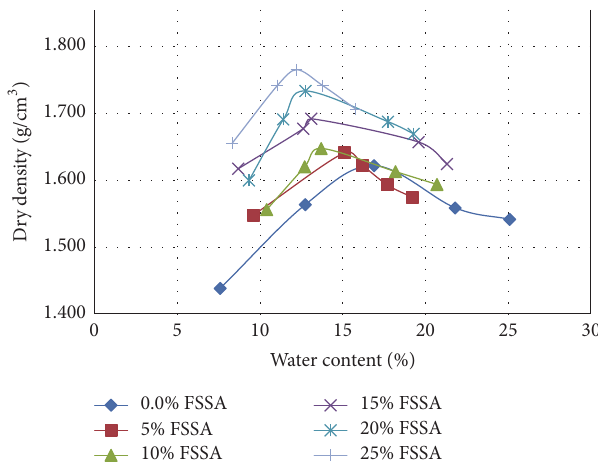
Figure 4: Compaction curves of samples with the FSSA additive.